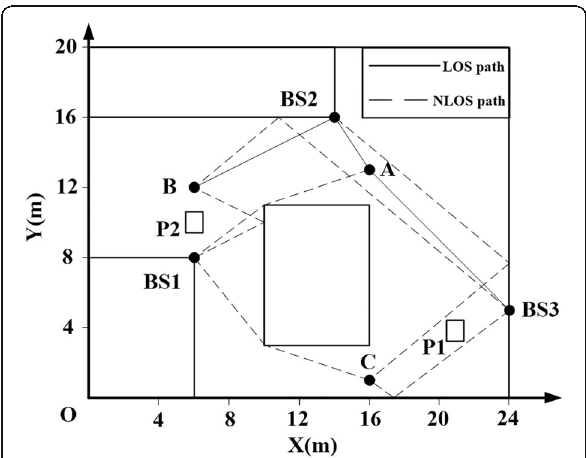
To evaluate the performance of the proposed VS method, simulations have been conducted. As shown in Fig. 2, three BSs were located at BS1 (6, 8), BS2 (14, 16), and BS3 (24, 5), respectively. The MS was located at three test points, A (13, 16), B (6, 12), and C (16, 1). The first detectable path between every an- chor and every test point were assumed as the figure shows. We also set two people, P 1 and P 2, so that the LOS path may be not the first detectable path in some conditions. When the MS was located at point A, two paths were LOS and the other one is one- bound scattering path; when at point B, one path was LOS and the others were one-bound scattering paths; when at point C, all three paths were one-bound scattering paths. Figures 3 and 4 illustrates the root mean square error (RMSE) comparison and the cumulative distri- bution function (CDF) comparison among the SDP (semidefinite programming) algorithm [17], ML [10], and TSWLS [10] estimators with and without using our VS method respectively with σ i = 1 m. One thou- sand independent runs are simulated to obtain the RMSE. The CRLB in Fig. 3 is obtained in the situ- ation which the indoor signal channel is complicated, and we assume that p 1 i ¼ p 2 i ¼ … p k i i . As Figs. 3a and